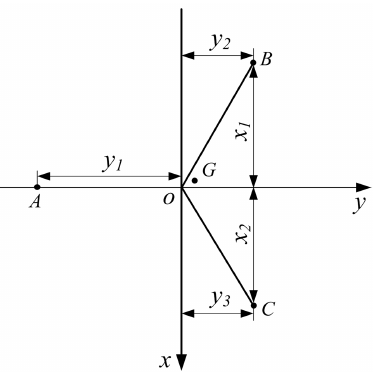
Figure 2. Measurement coordinate system of the centroid.